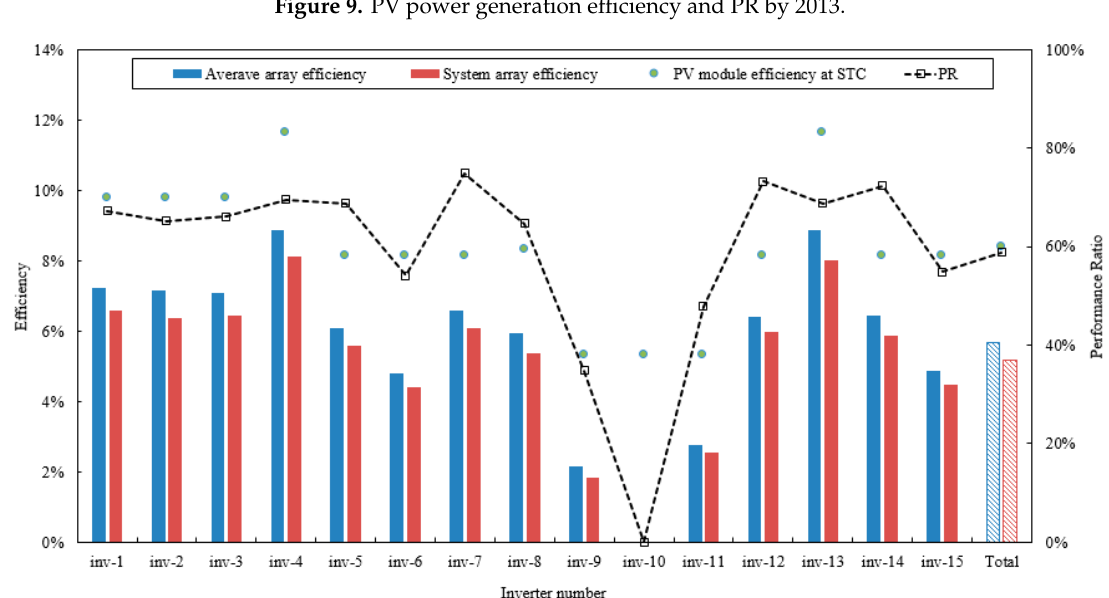
ffi ciency and PR by Figure 10. PV power generation efficiency and PR by 2014. Figure 10. PV power generation e Figure 10. PV power generation efficiency and PR by 2014.